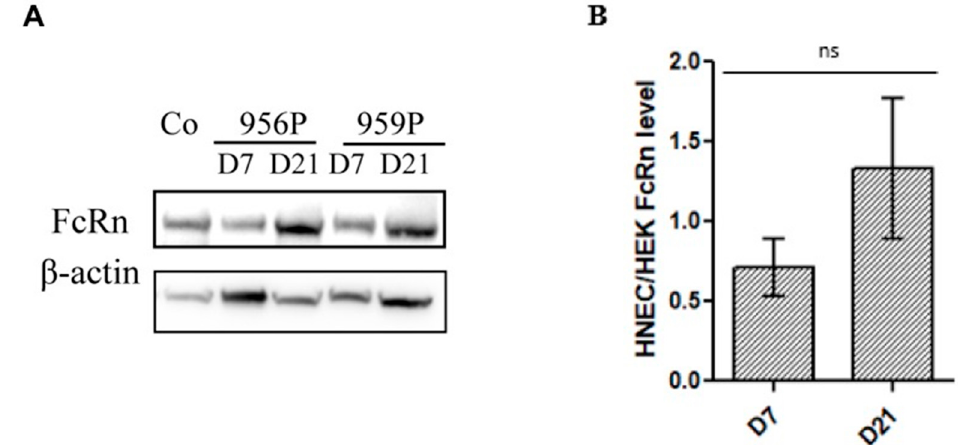
Figure 3. Neonatal Fc receptor (FcRn) protein expression in air–liquid interface culture of human nasal epithelial cells. ( A ) Western Blot analysis of FcRn expression using anti-FcRn antibody (1/500, Santa Cruz Biotechnology, sc-271745) in HNEC on day 7 (D7) and day 21 (D21) in two out of five representative different cultures (956P and 959P). HEK 293 cell extract was included as positive control (Co). β -actin was used as control for equal protein loading. ( B ) FcRn expression was normalized on β -actin. FcRn expression in the five cultures of HNEC were then reported to the expression level of HEK control cell line. Results are presented as mean +/ − SEM. * p < 0.05.